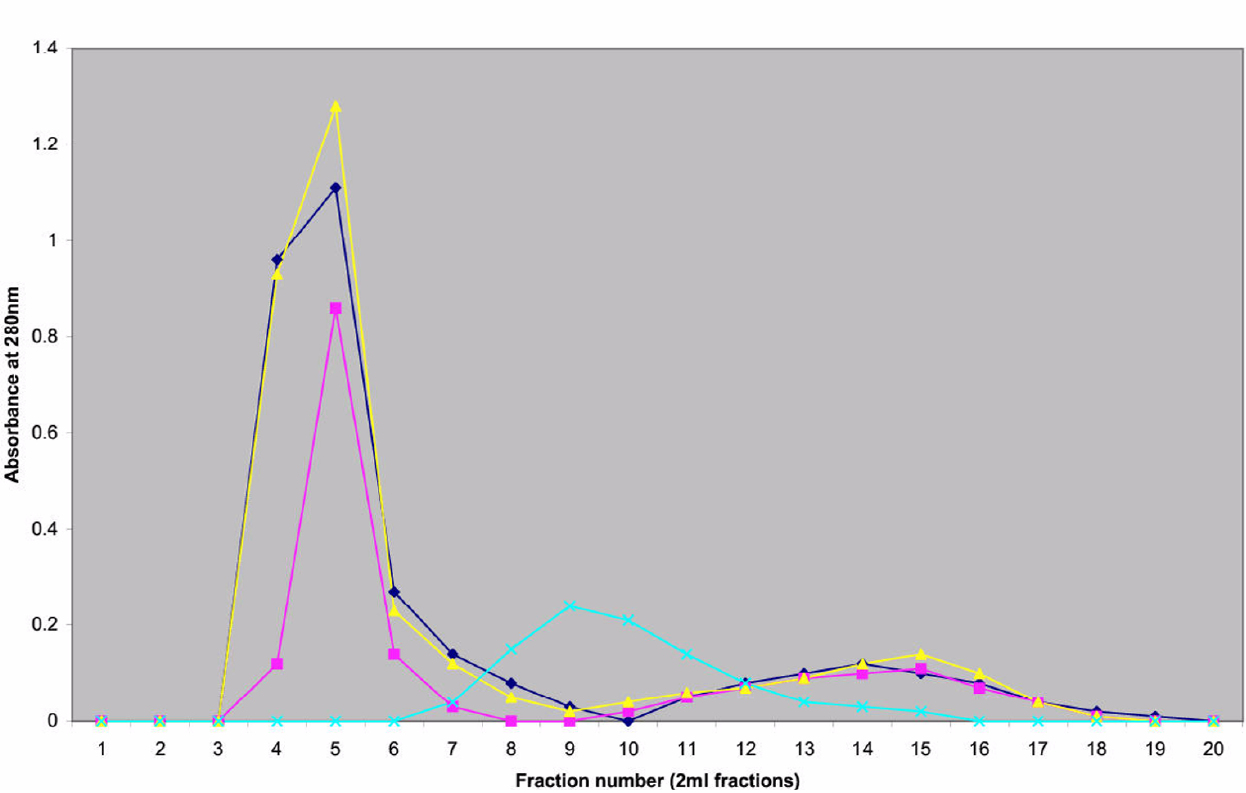
Figure 2 Gel Filtration of Recombinant Galectin-1 and Variants. Galectin-1 preparations purified by metal chelation chromatog- raphy were subjected to gel filtration on a Sephadex G-50 gel filtration column (60 × 1 cm; equilibrated in 30 mM Tris-HCl buffer pH 7.5). Fractions of 2 ml were collected, and absorbances at 280 nm measured. Њ Normal galectin-1 ▪ N46 D mutant P79R mutant Bacterial